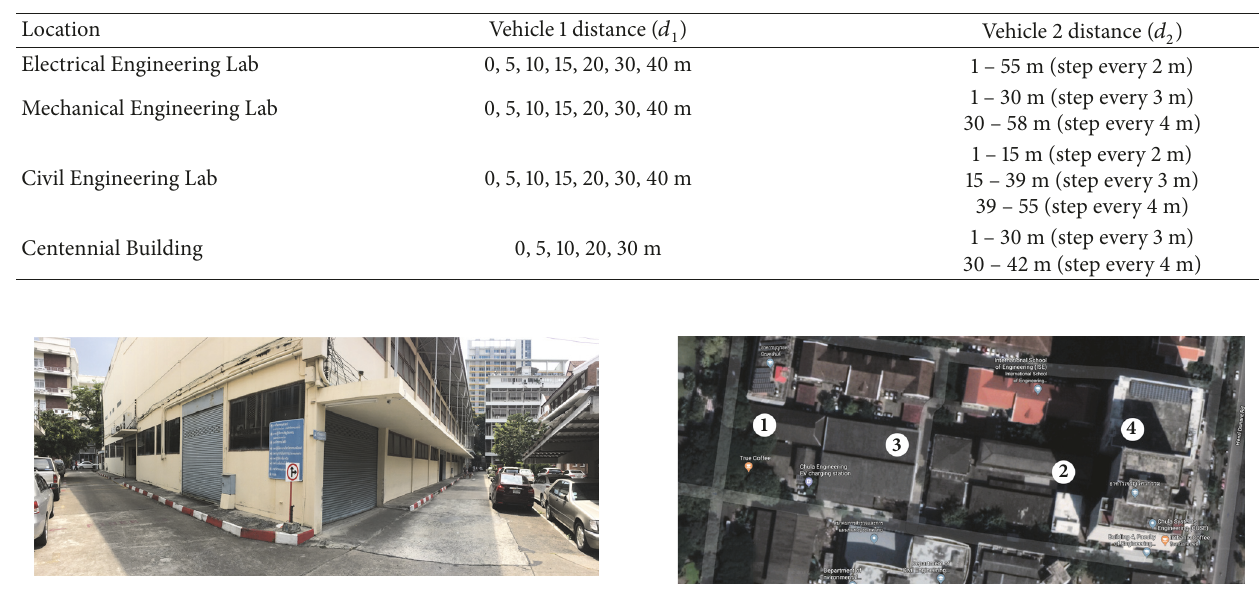
Figure 6: Civil Engineering Lab.